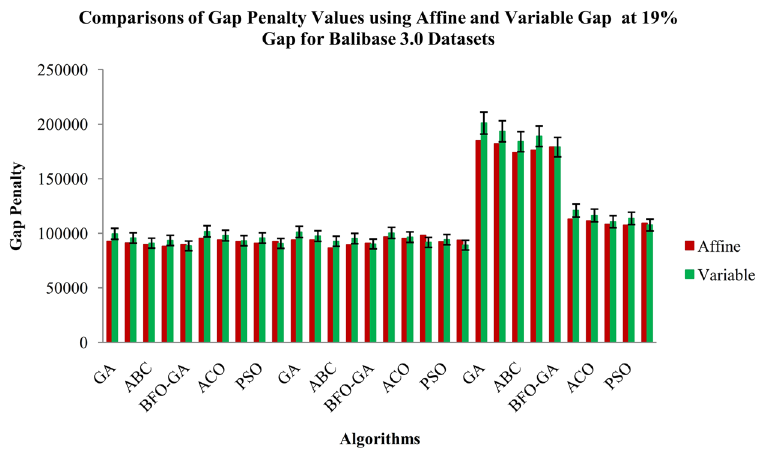
Figure 4. Comparisons of Gap Penalty values for BAliBASE datasets using Affine and Variable Gap penalty for the proposed and existing algorithms.